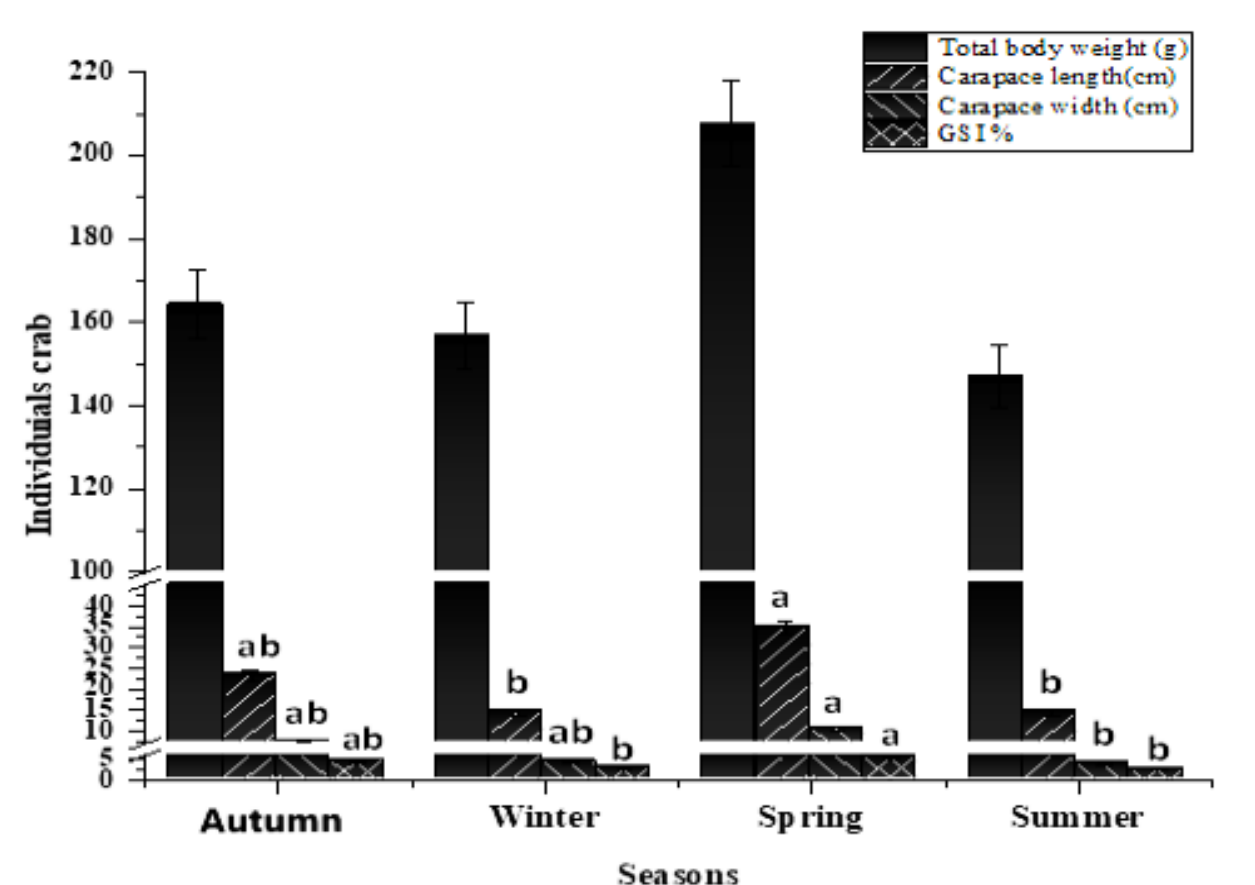
Figure 2. Total body weight (g), Length, Width (cm), and Gonado-somatic index % in males of C. sapidus characteristics in Abu-Qir (June–November 2019), means ± SE Columns superscripted by different letters within the same axis are significantly different ( p < 0.05).